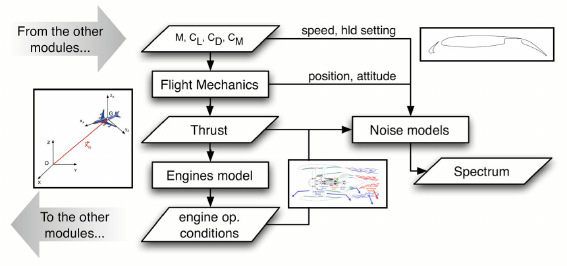
Figure 4: Detail of the FRIDA flowchart involving noise